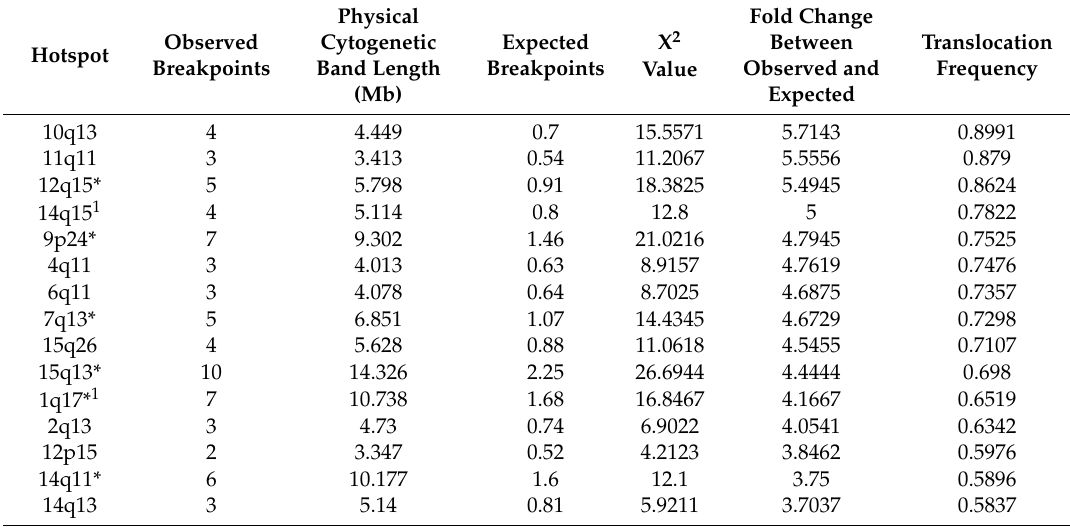
Table 11. Potential hotspots for rearrangement in the pig genome based on translocation frequency.